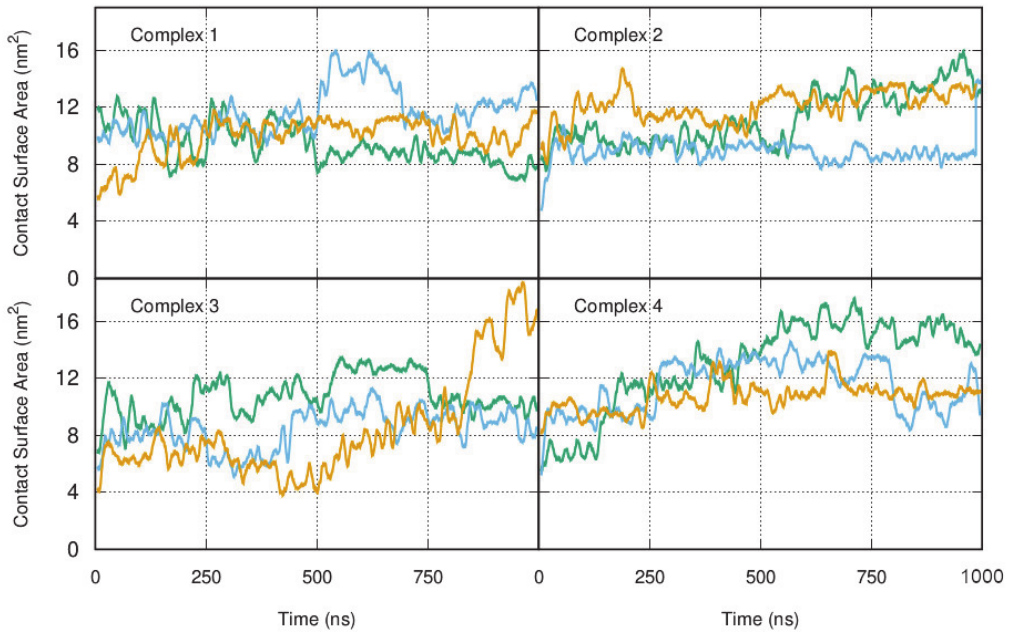
Figure 3. The contact surface area between wt:p10 and the dsDNA calculated for all MD simulations. Replicate 1, 2 and 3 from each simulated system is respectively colored in green, blue, and yellow.